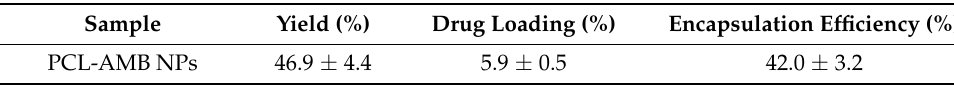
Table 2. Drug loading and encapsulation efficiency of PCL-AMB NPs.